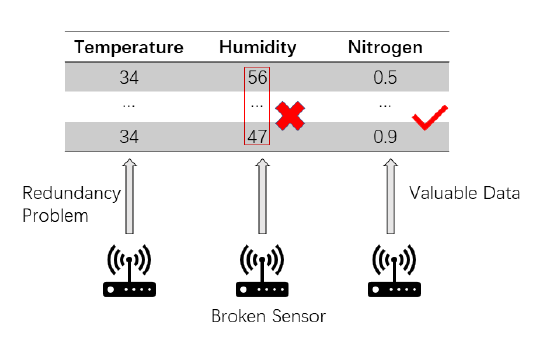
Figure 1. Kinds of problem in the Internet of